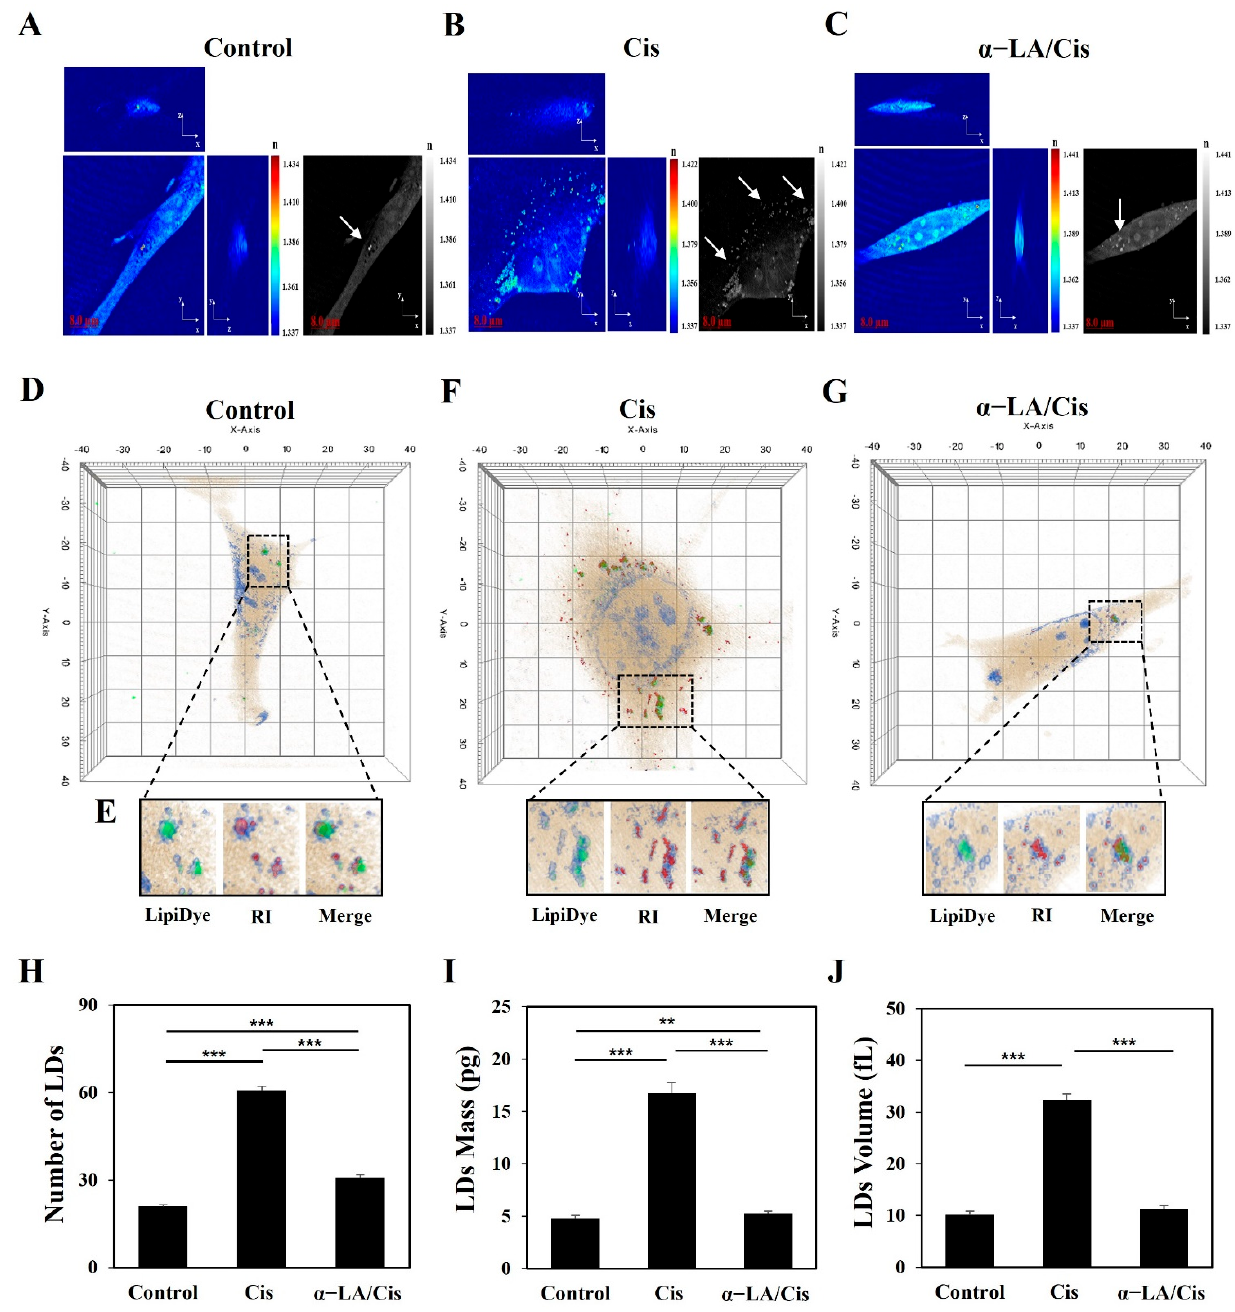
Figure 2. The measurement of LDs through 3D-ODT using the RI values of HEI-OC1 cells. ( A – C ) 2D isosurface images for the control group, cisplatin group, and α -LA/Cis group, respectively. The white arrows indicate LDs (high-RI regions), and the colored bars indicate the 2D-rendered RI range of 1.3 to 1.4 with an 8 μ m scale bar. ( D – G ) Cell images labeled by RI analysis. The LDs regions in cells are marked with black dotted lines. The region of LDs under the LDs stain in ( E ) is marked in green, and the RI is marked in red. ( H – J ) LDs numbers, masses, and volumes, respectively, measured through RI analysis of 3D images showed high levels in the cisplatin group, while the levels are recovered in the α -LA/Cis group. In 20 independent experiments, 600 cells from each group were compared, and the results are presented as the means ± SDs (** p < 0.01, and *** p < 0.001, determined using one-way